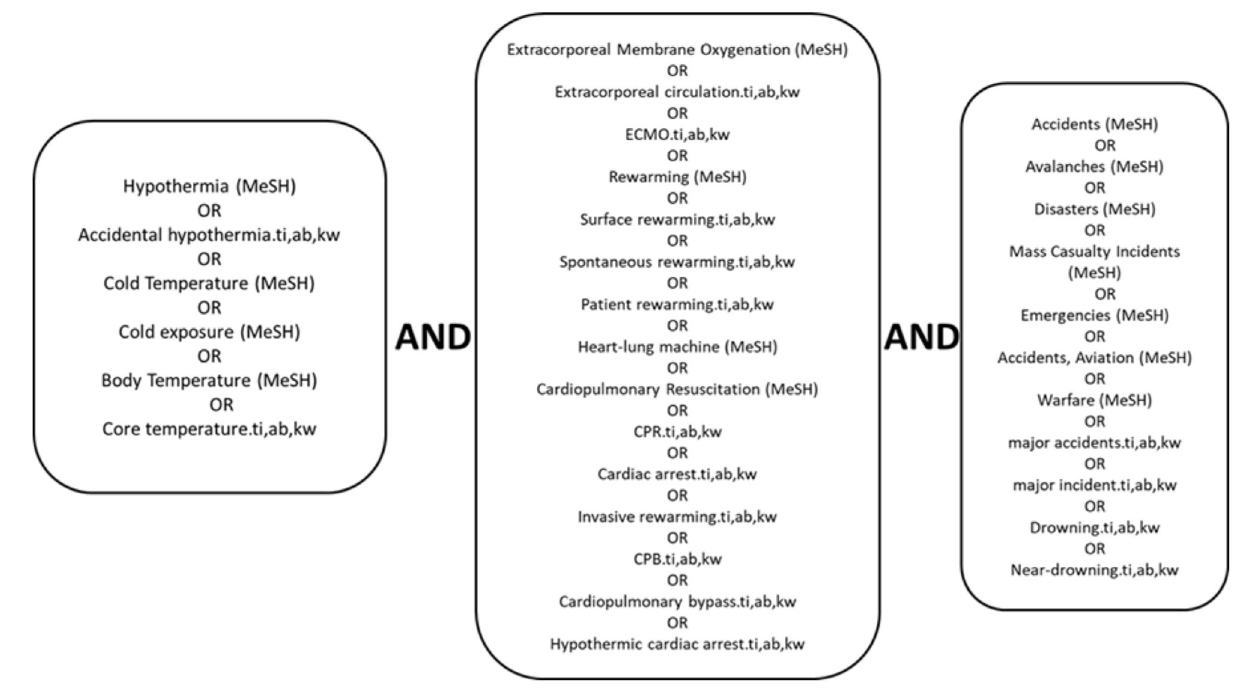
FIGURE 1 | Search strategy. Systematic literature search of August 2020 in the following databases: Ovid MEDLINE (R) In-Process & Other Non-Indexed Citations. Ovid MEDLINE (R) Daily and Ovid MEDLINE (R) 1946 to Present and Embase Classic + Embase 1947 to Present. Medline subject headings; ti, titles; ab, abstracts; kw,